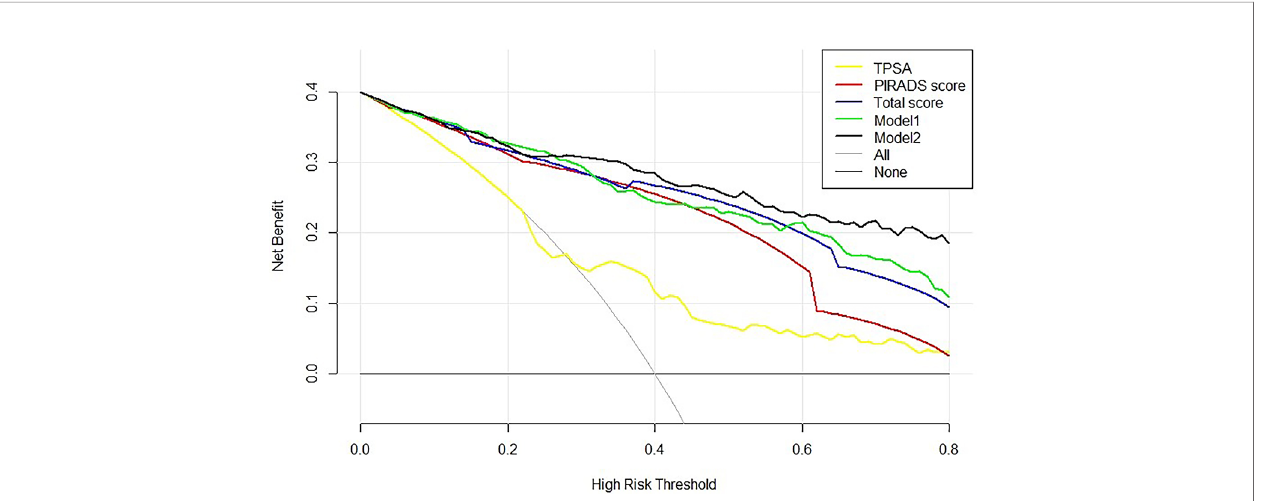
FIGURE 3 | Decision curve analysis of the PSA, bpMRI score, and prediction models for csPCa. The net bene fi t curves for models are shown in this fi gure. The x -axis indicates the threshold probability for critical care outcome and the y -axis indicates the net bene fi t. For the baselines, solid transverse line = net bene fi t when all patients are considered as not having the outcome; dashed line = net bene fi t when all patients are considered as having the outcome. Solid black line = model 2, solid green line = model 1, solid blue line = Total score, solid red line = PI-RADS score, and solid yellow line = PSA. The preferred model is model 2, the net bene fi t of which was highest over the range of other parameters. Model 2 with the greatest net bene fi t at a given risk threshold had the greatest clinical value.